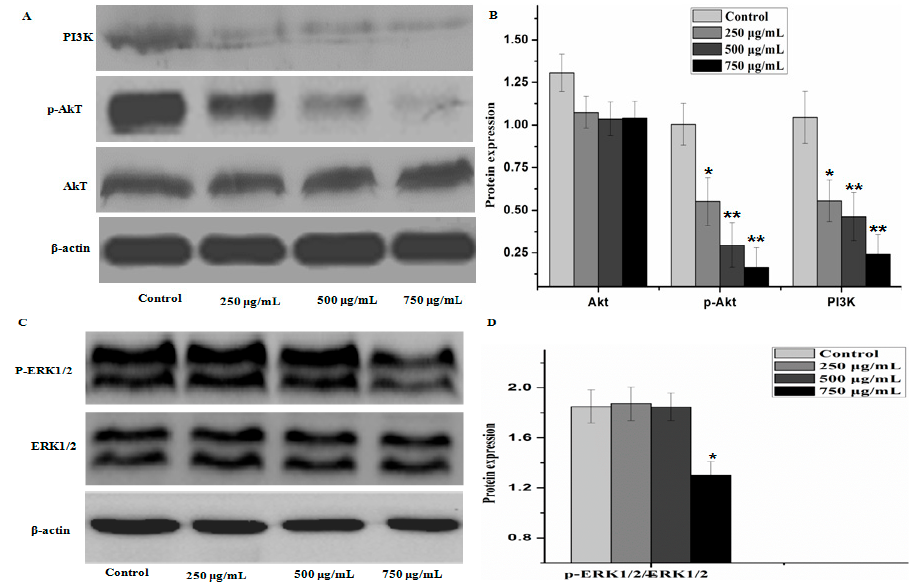
Figure 8. PZH triggered activation of PI3K/Akt signal pathway signaling. The relative optical densities were indicated in B and D. Cells were treated with 250, 500 and 750 μ g/mL PZH for 24 h and then were lyzed for the determination of the indicated protein levels by western blot. Actin was used as internal control. * p < 0.05, ** p < 0.01 vs. control group. Data are mean ± SD. ( A ) Protein expresion of PI3K, p-AKT and AKT; ( B ) The relative optical densities of PI3K, p-AKT and AKT; ( C ) Protein expresion of ERK1/2 and p-ERK1/2; ( D ) The relative optical densities of ERK1/2 and p-ERK1/2.